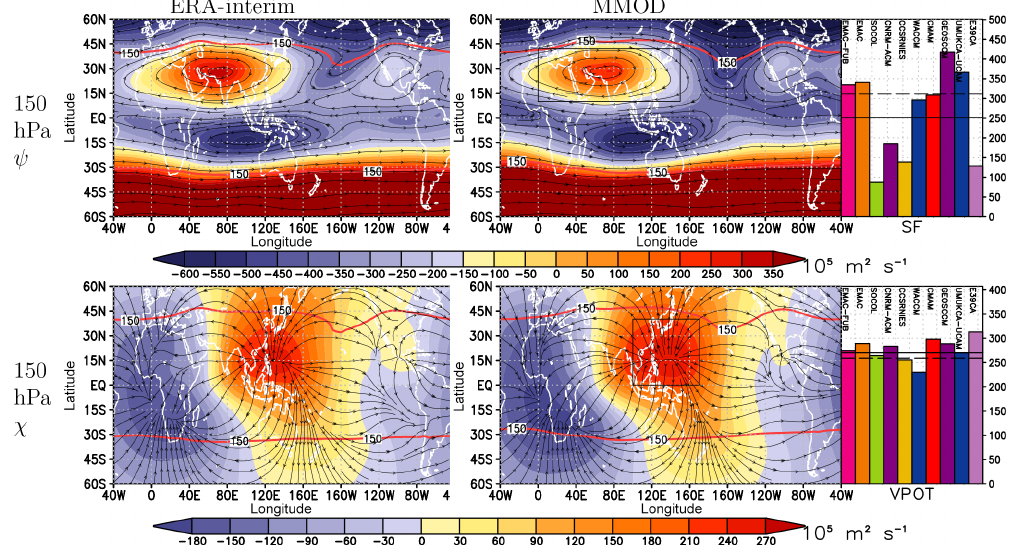
Figure 2. Top: long-term monthly-mean stream function (in 10 5 m 2 s − 1 ) for JA at 150hPa in 60 ◦ S–60 ◦ N; left: ERA-Interim (35 years); right: the multi-model average (45 years). Streamlines indicate the rotational horizontal wind. Indicated with the red solid contour is the intersect of the tropopause with 150hPa. The maximum of individual models within the area marked by the black rectangle is displayed as a bar chart, where the solid horizontal line represents the multi-model average and the dashed horizontal line represents the maximum of ERA-Interim. Bottom: as above but for the velocity potential (in 10 5 m 2 s − 1 ) with streamlines of the divergent horizontal wind.